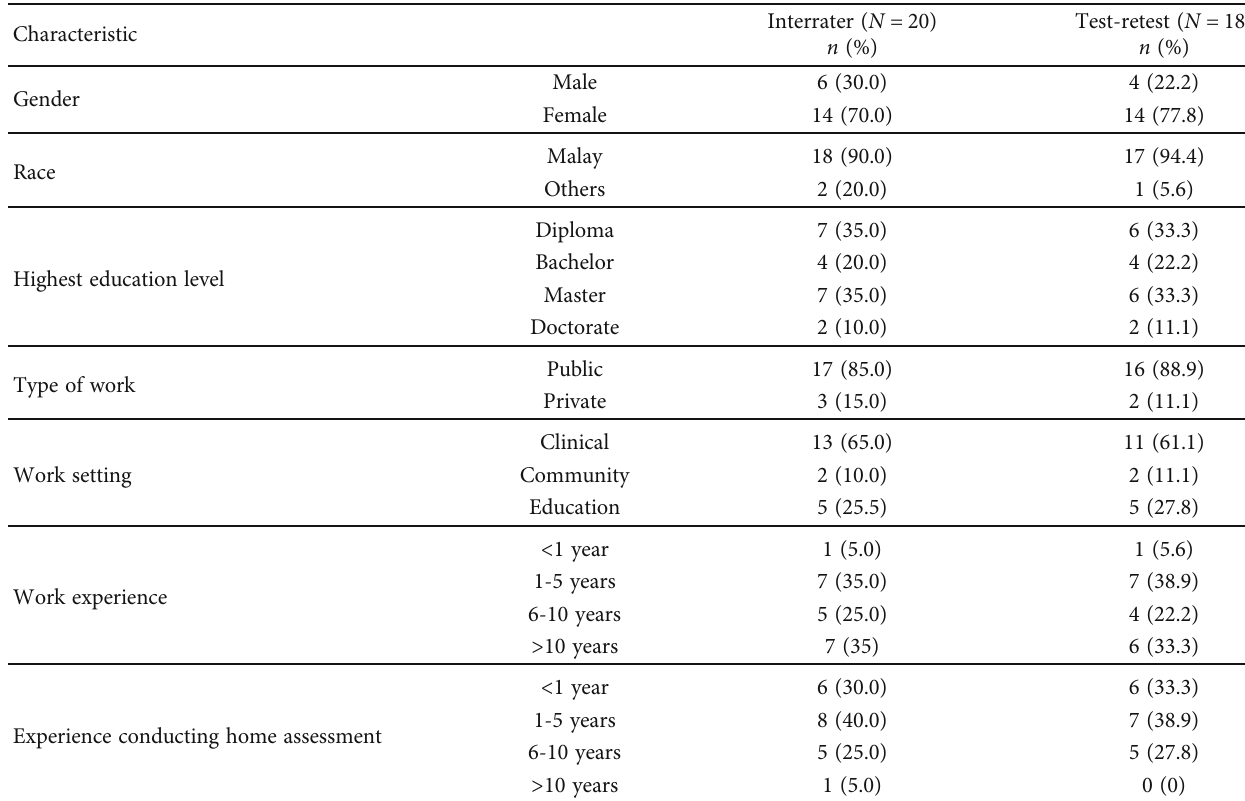
Table 2: Demographics of comparison raters for interrater and test-retest